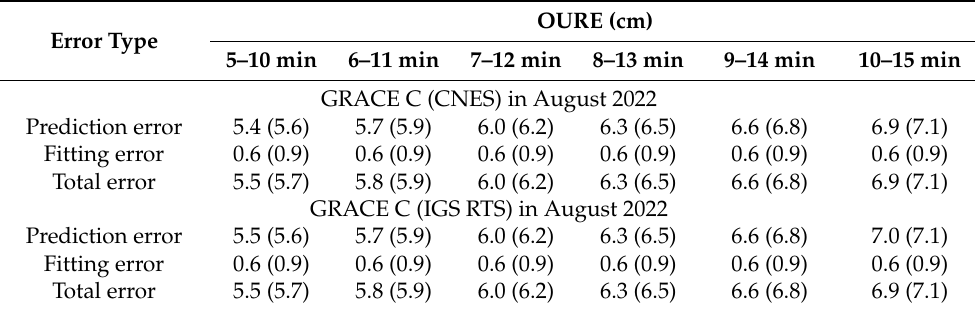
Table 12. Total error budget (in OURE) of the real-time GRACE C satellite orbits from 6 to 12 August 2022 with less healthy data status. The values are given for different prediction time windows. The results without outlier exclusions are given in